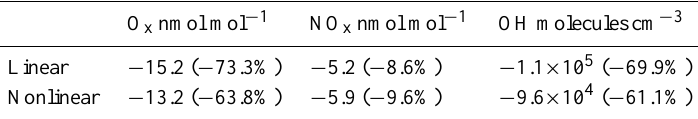
Table 7. The linearly summed influences (calculated as DUST H − NO DUST + DUST J − NO DUST) and the nonlinearly combined influ- ences (calculated as DUST H + J − NO DUST) of dust on the daily average mixing ratios y of O x , NO x and the daily average concentration C of OH through the heterogeneous removal reactions and the photolysis rates decrease for the T04 case. The relative influences (i.e. the influences normalized by NO DUST) are shown in